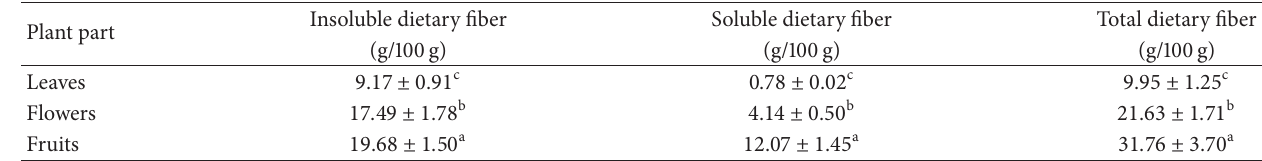
Table 5: Insoluble and soluble dietary